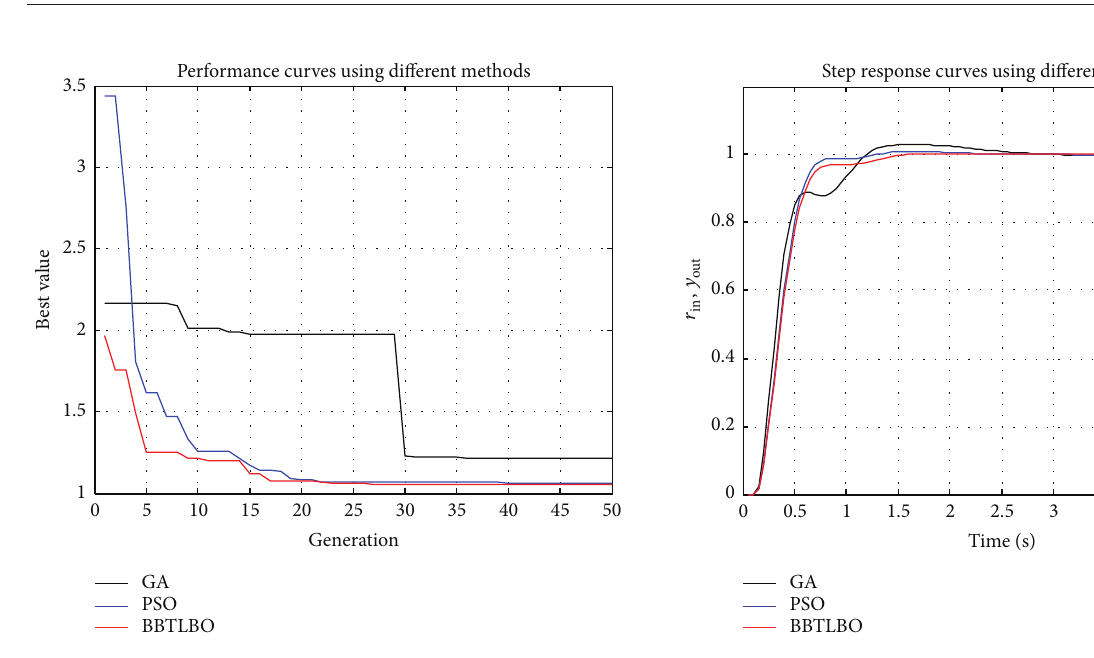
Figure 7: Performance curves using different methods. Figure 8: Step response curves using different